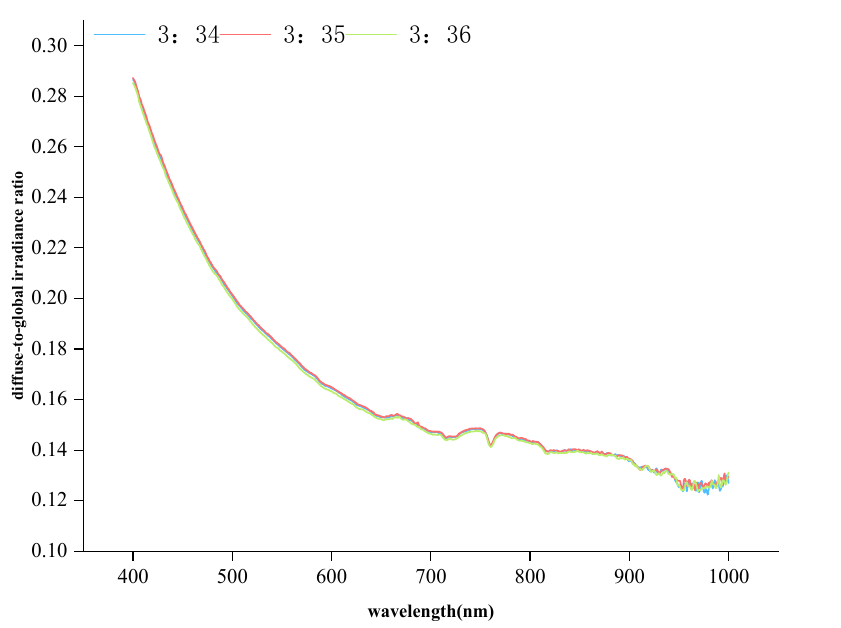
Figure 7. The measured spectrum of the diffuse-to-total ratio measured by AG-512 SSIR. Using measured diffuse-to-global irradiance ratio α ( λ ) and SRF of MUX R ( λ ) , the diffuse-to-global irradiance ratio of each MUX band was calculated as shown in Table 4.